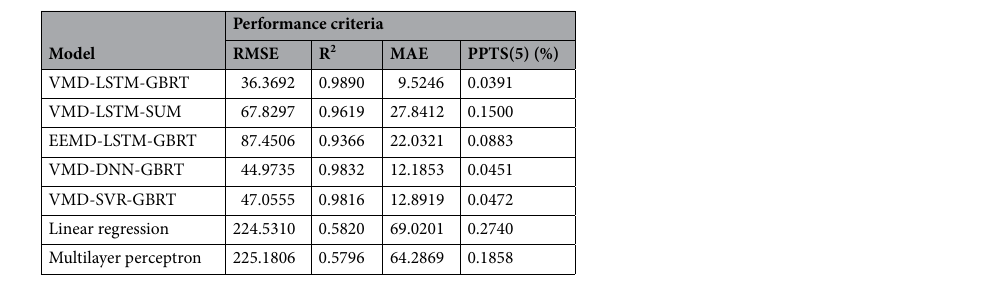
Table 3. Comparison of the forecasting performances using different